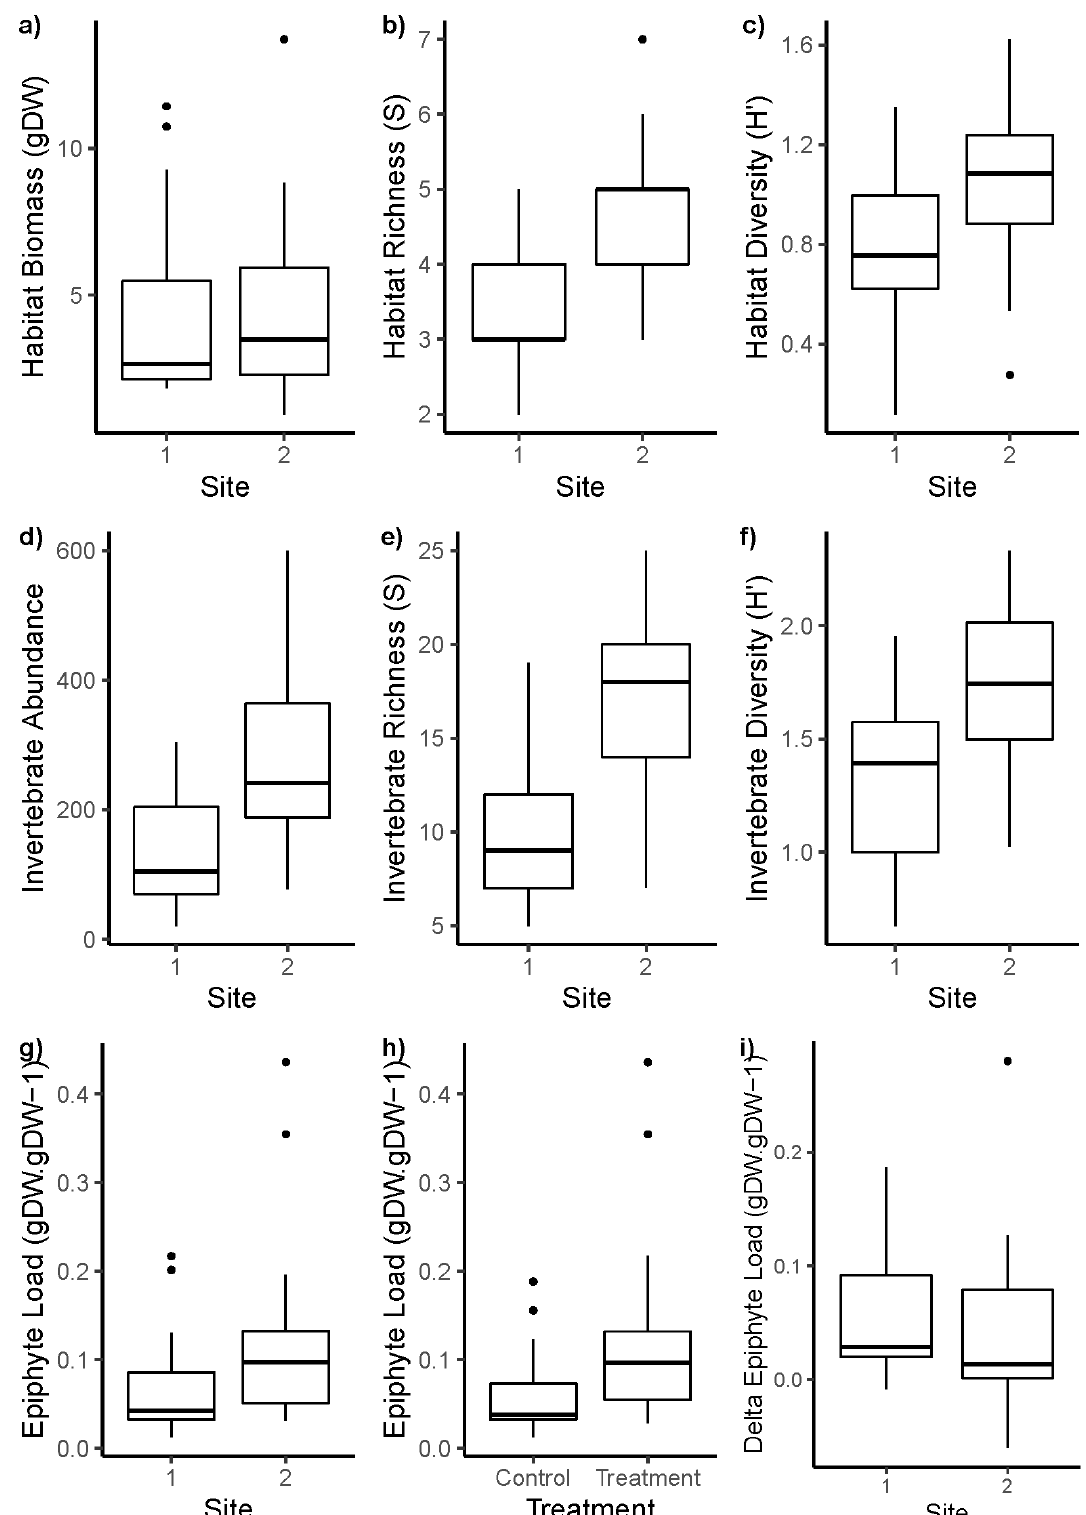
Figure 2. The e ff ect of site on each of the habitat and invertebrate variables measured in the study ( a – f ). The e ff ect of site ( g ) and treatment ( h ) on epiphyte load (gDW · gDW − 1 ) and ( i ) the di ff erence (delta) in epiphyte load (gDW · gDW − 1 ) between paired controls and treatment plots for each site.